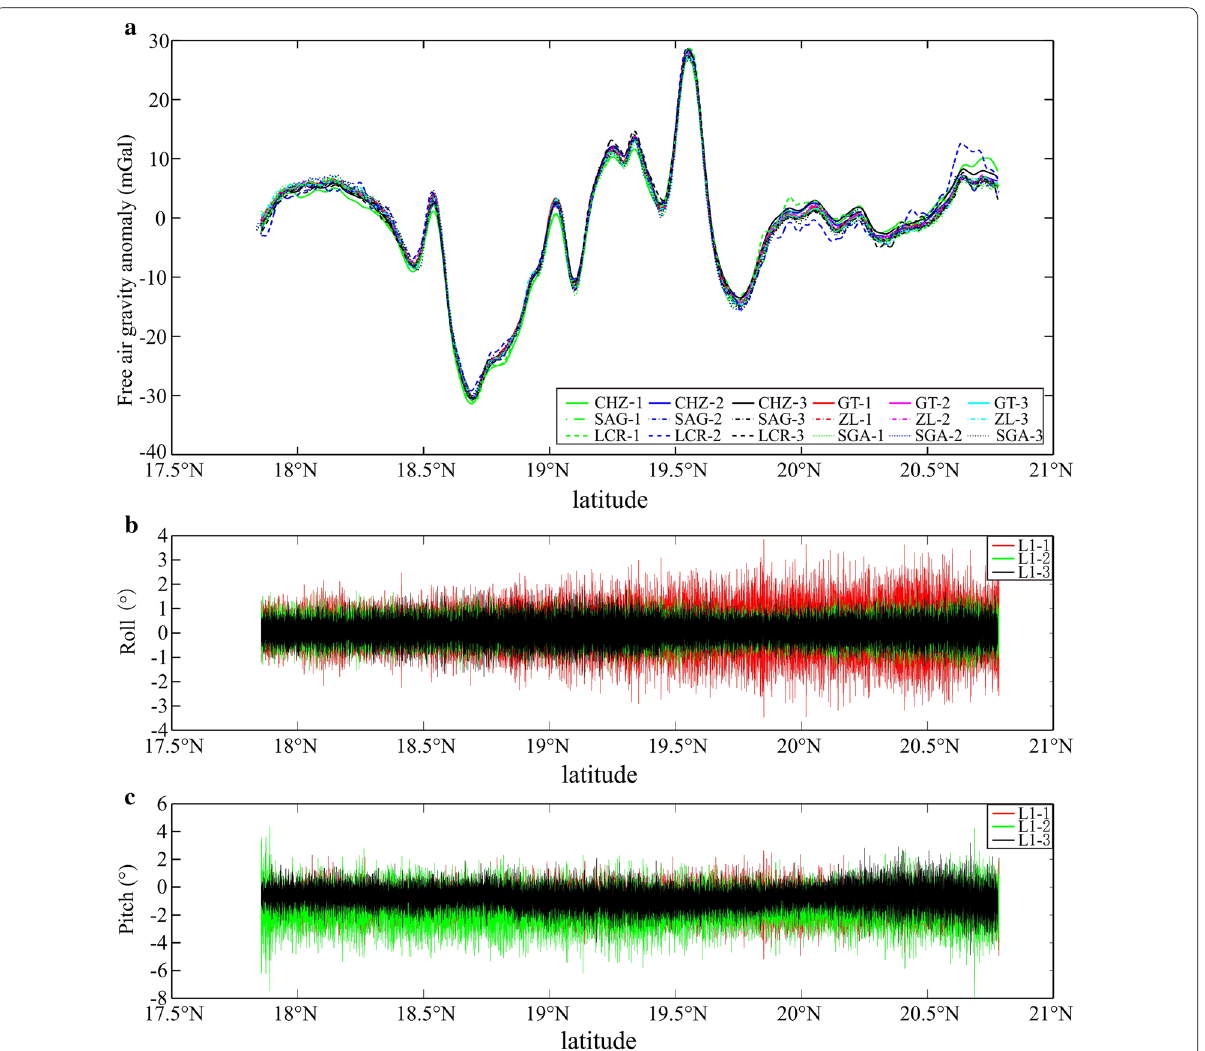
Fig. 4 Comparison of free-air gravity anomaly ( a ) results from measurements collected with all the gravimeters on the three times repeated Line 1 (ref. to Fig. 3); b , c sea conditions during the survey can be envisaged from roll and pitch vessel